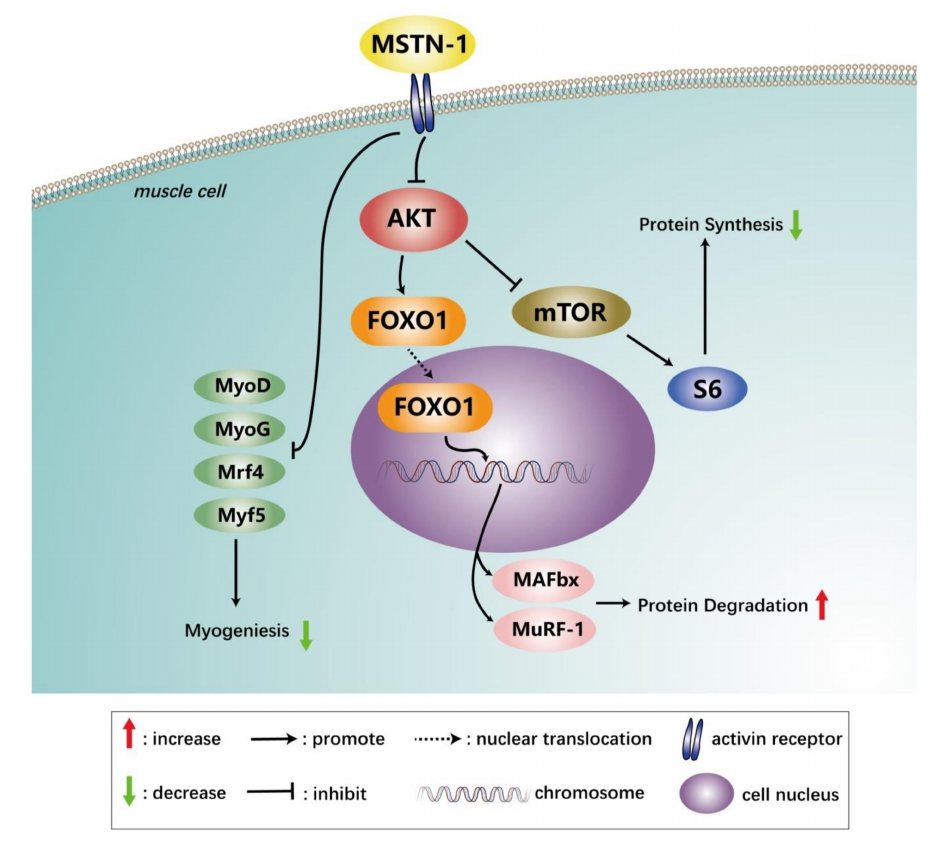
Figure 12. The proposed mechanism of myostatin-1 on muscle cell of Japanese flounder in the present study.